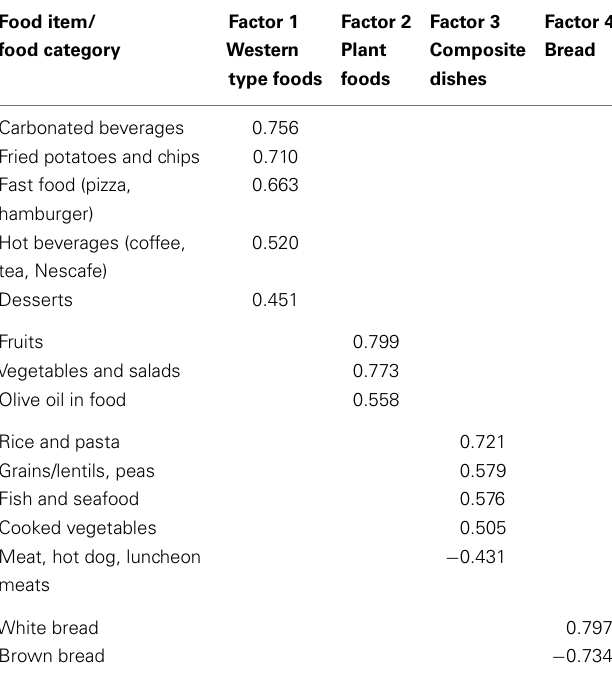
Table 3 | Pattern loading of the four major factor solutions after promax rotation.